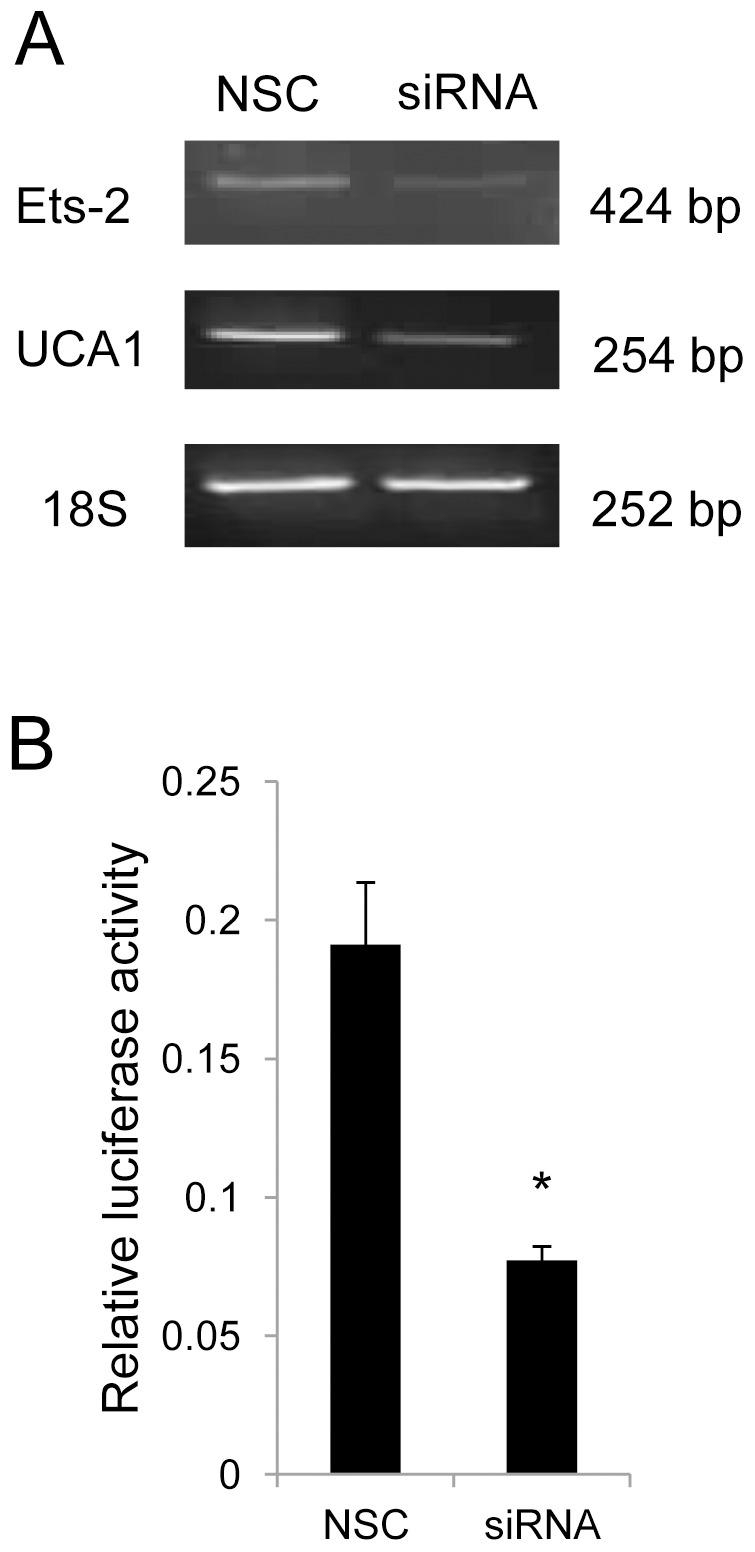
Ets-2 is essential to the transcription regulation of the UCA1.(A) Expression of Ets-2 and UCA1 was measured by RT-PCR following Ets-2 specific siRNA or scrambled siRNA treatment in BLZ-211 cells. 18 S rRNA was used as an internal control. (B) Luciferase assay. Ets-2 specific siRNA or scrambled control siRNA was co-transfected with pGL3-UCA1-1200 into BLZ-211 cells. Values represent means ± SD of at least three independent experiments. *P<0.05. NSC: non-specific control siRNA.